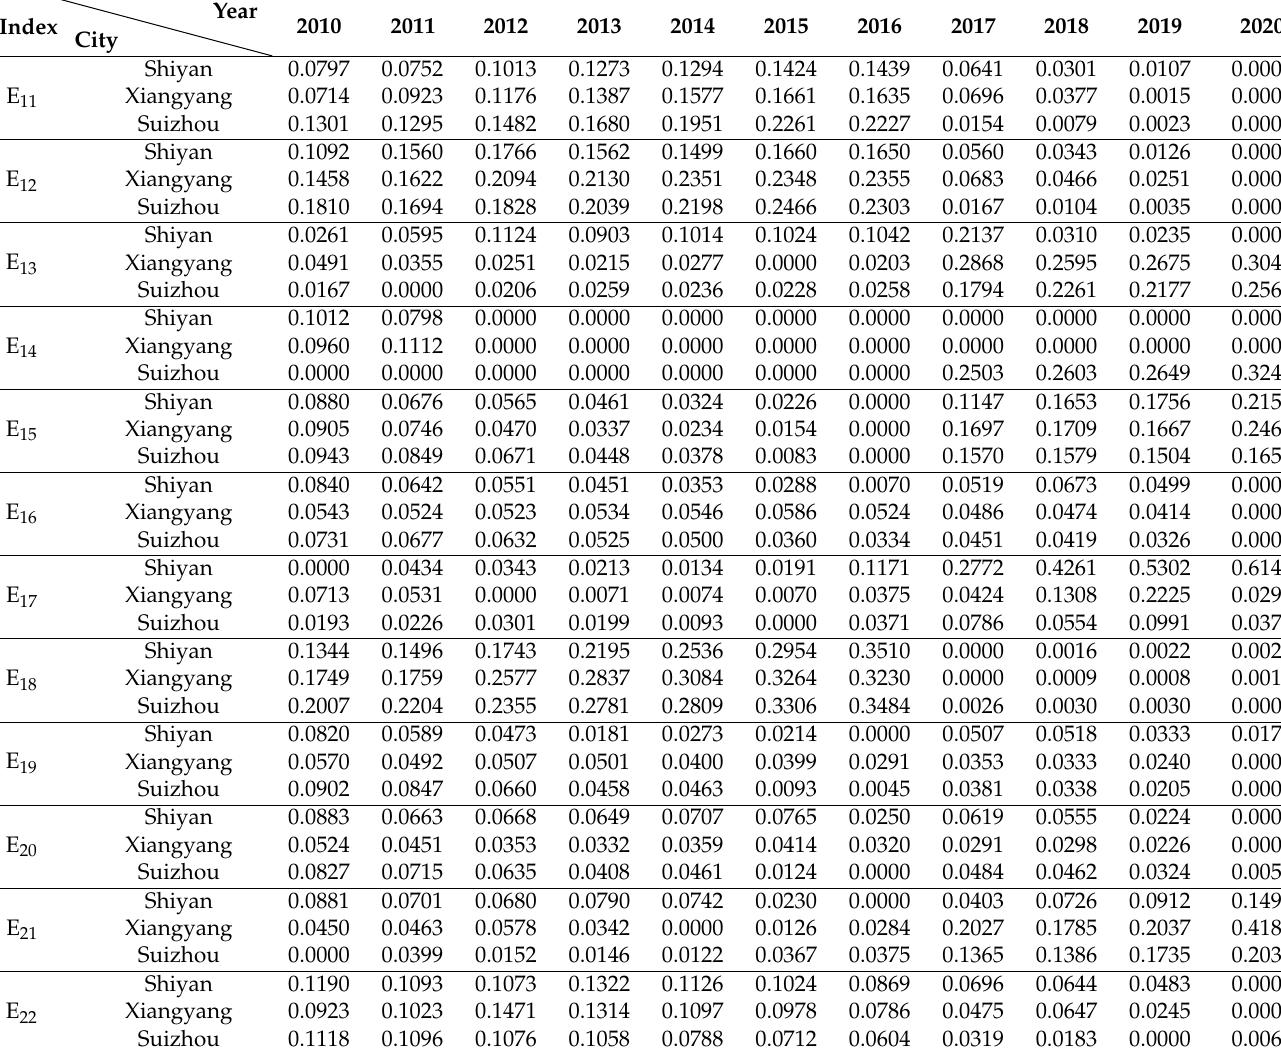
Table 5. Obstacle degree of each indicator in Shiyan City, Xiangyang City, and Suizhou City